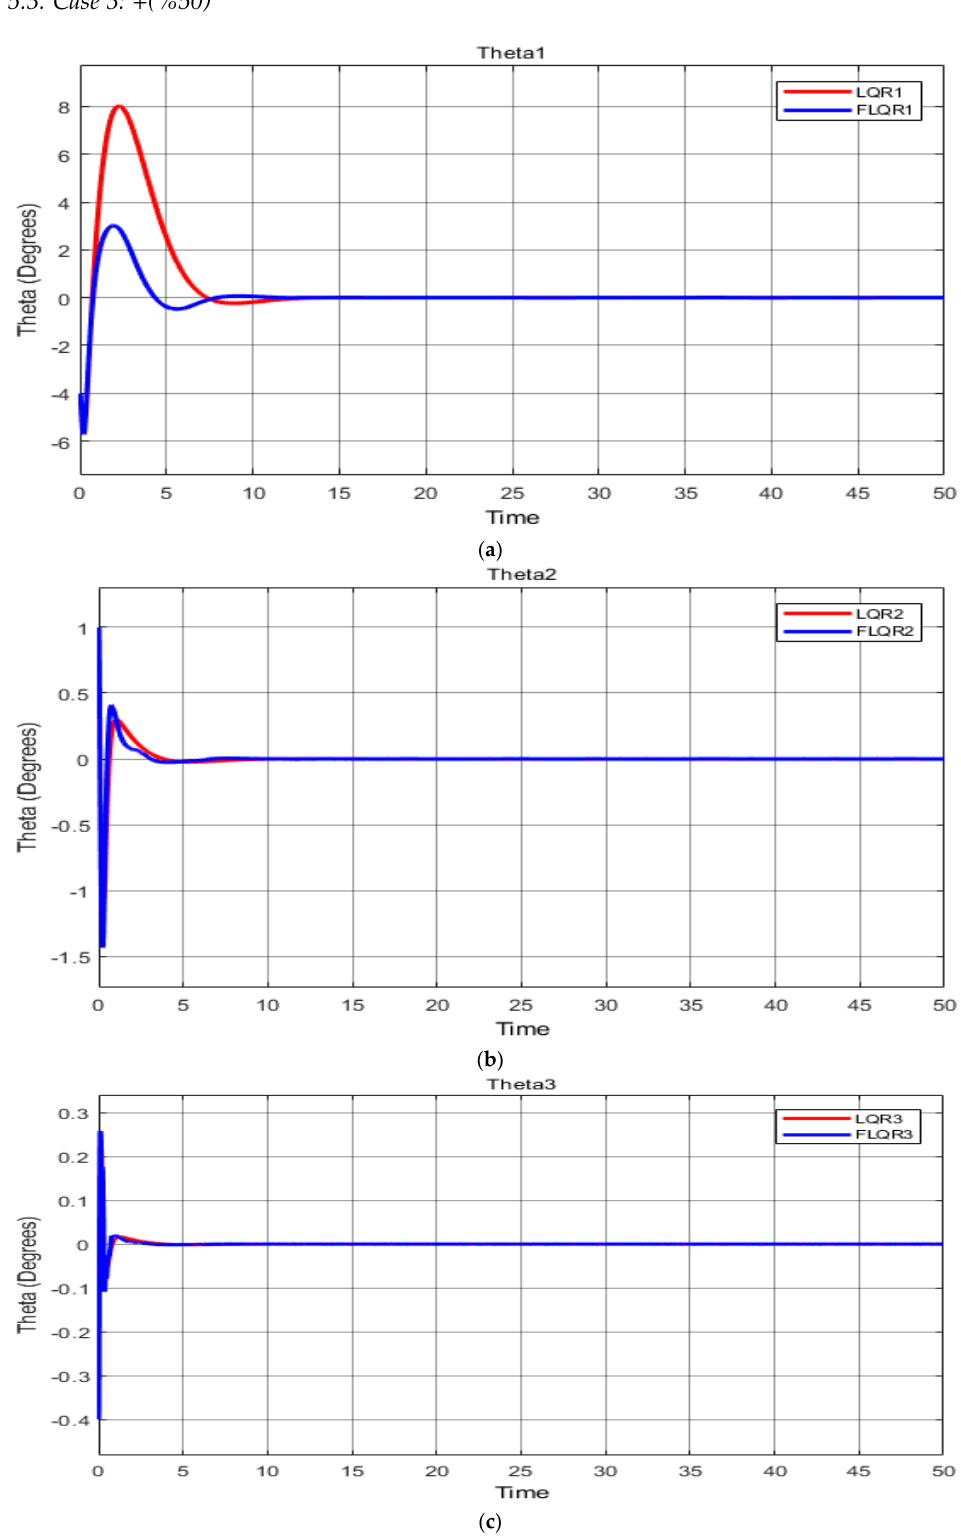
Figure 11. ( a ) The system response for upper link of Robogymnast in Case 3 (T1); ( b ) The system response for second link of Robogymnast in Case 3 (T2); ( c ) The system response for 3rd link of Robogymnast in Case 3